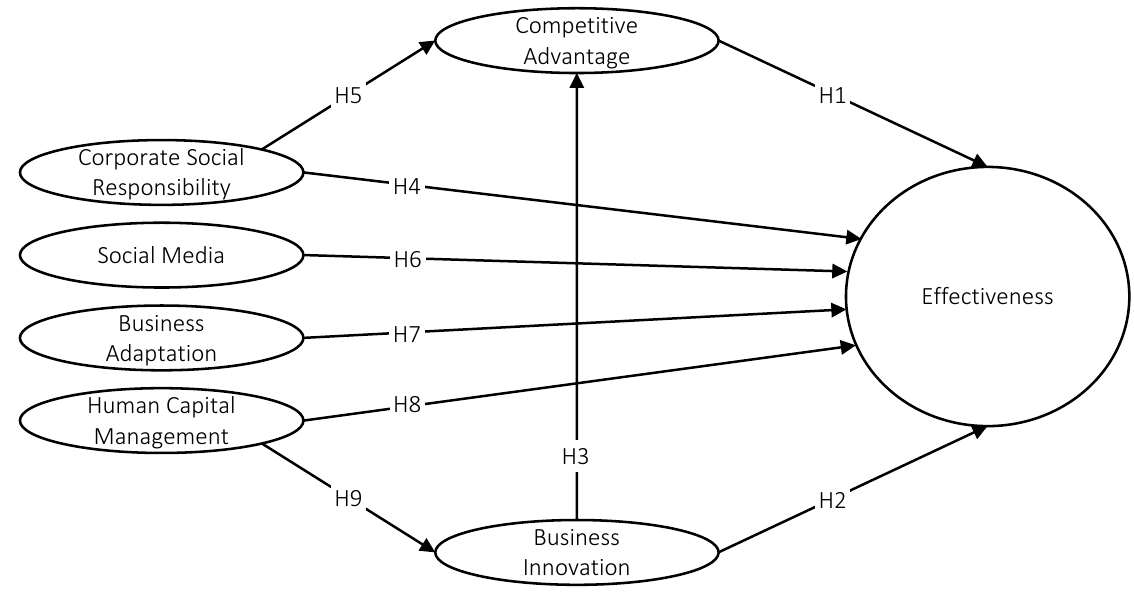
Figure 1. Conceptual